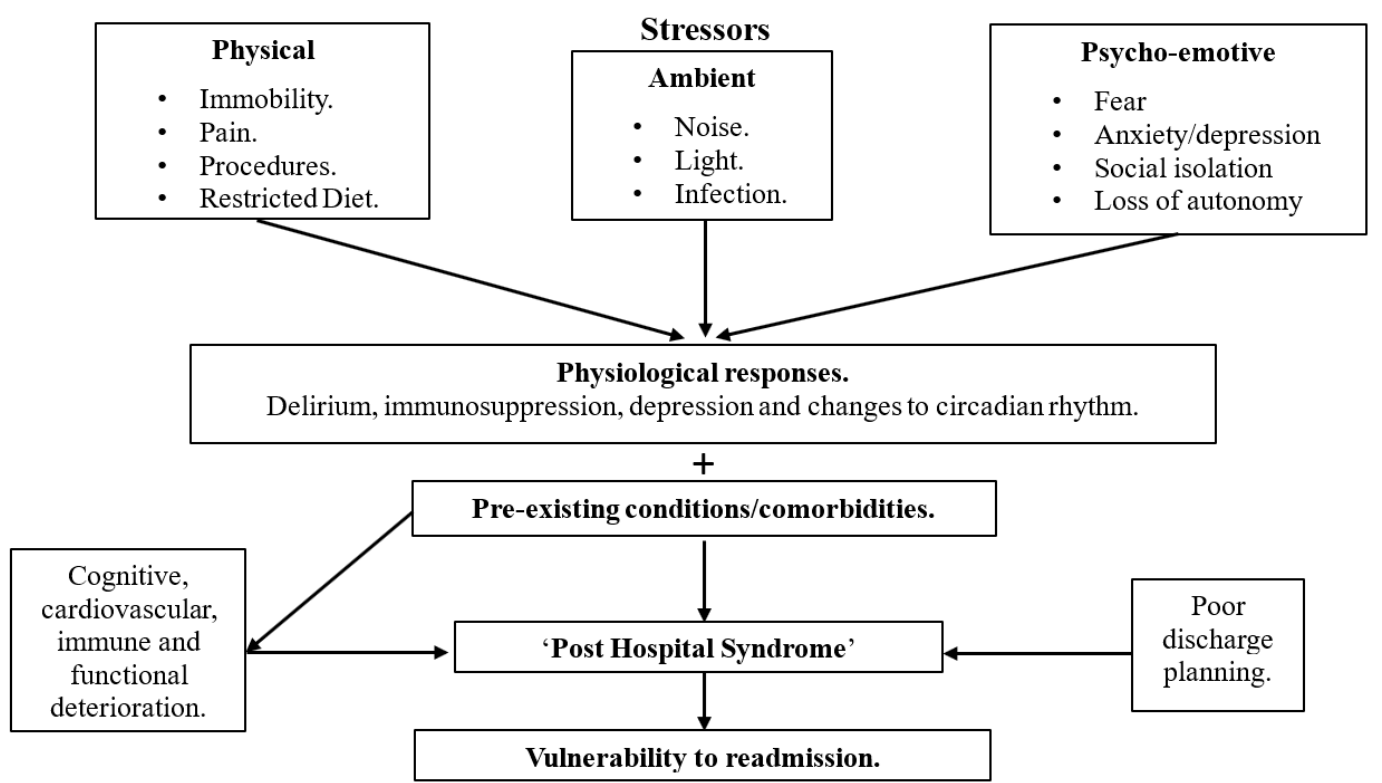
Figure 2. Possible mechanisms behind post-hospital syndrome that result in patient readmission. Adapted from Figure 1 (Mesquita et al. 2015) [26]. Sleep is a stressor that is partly physical, partly ambient and partly psycho-emotive. These in-hospital stressors result in physiological responses. In addition to pre-existing comorbidities, the cognitive, cardiovascular, immune and functional deterioration and poor discharge planning lead to an increased risk of post hospital syndrome. This then leads to patients having increased vulnerability to